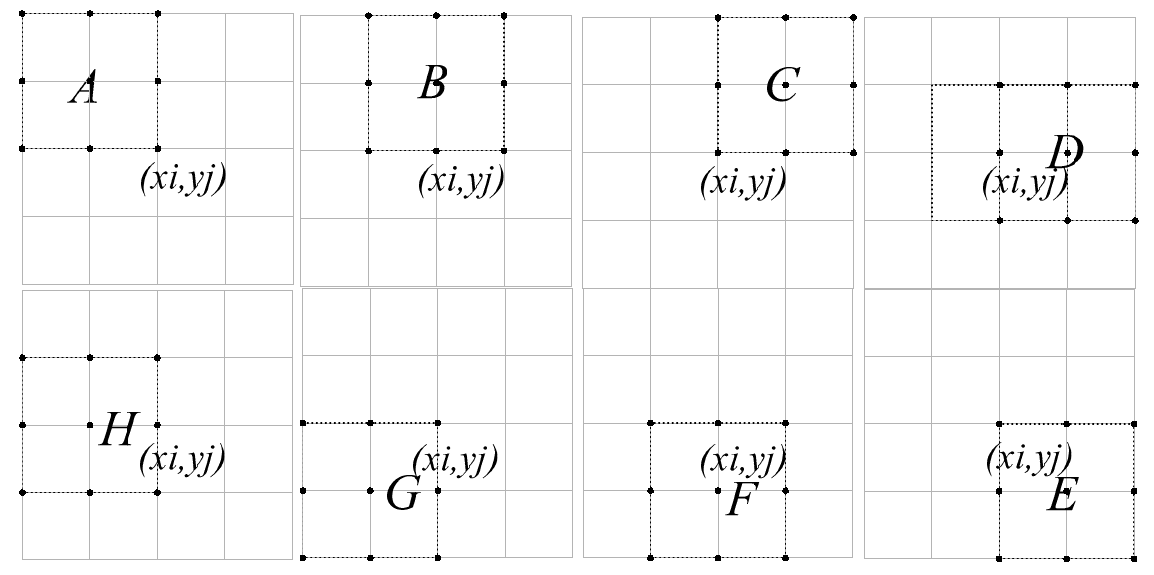
Figure 5. The cartogram of the window splitting in 8 directions.